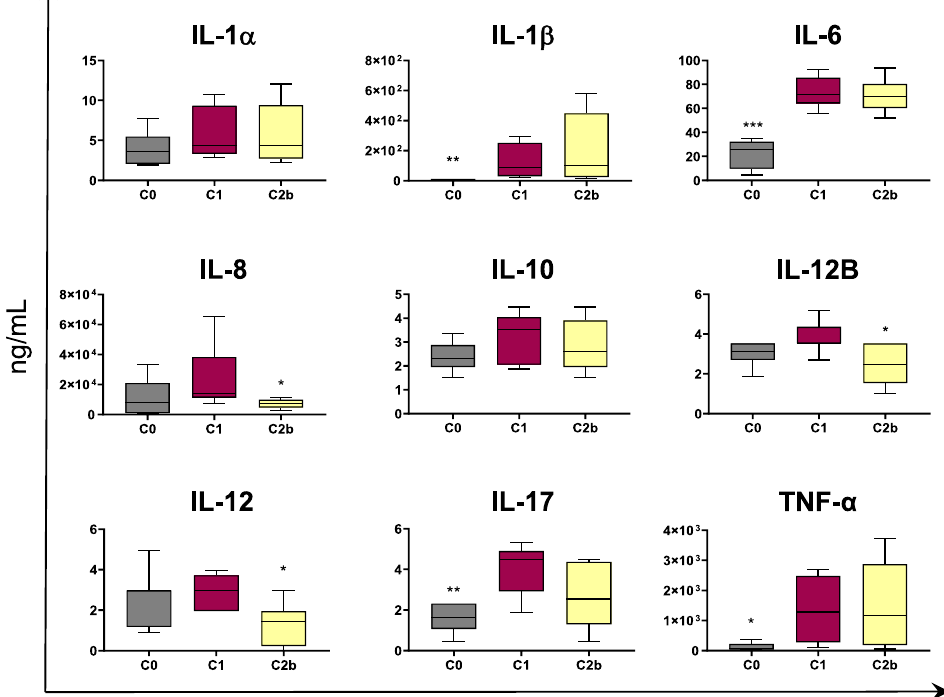
Figure 7. The 10 10 mEV impact on cytokine production by THP-1. Co-culture of Caco-2 and THP-1 cells were left untreated (basal condition, C0) or stimulated with IFN- γ and LPS (inflamed co-culture, C1). At 24 h post stimulation, 10 10 mEV suspension was added to both Caco-2 and THP-1 cells in inflamed co-culture (C2b). A total of 24 h later, culture supernatants were collected, and levels of cytokines were determined through ELISA. Data are presented as box-and-whisker plots displaying median and interquartile range (boxes) and minimum and maximum values (whiskers). Values of C0, C2a, C2b were compared to C1, using an ANOVA followed by Dunnett’s multiple comparison test or a Kruskal–Wallis test followed by Dunn’s multiple comparison test; * p < 0.05, ** p < 0.01 and *** p <